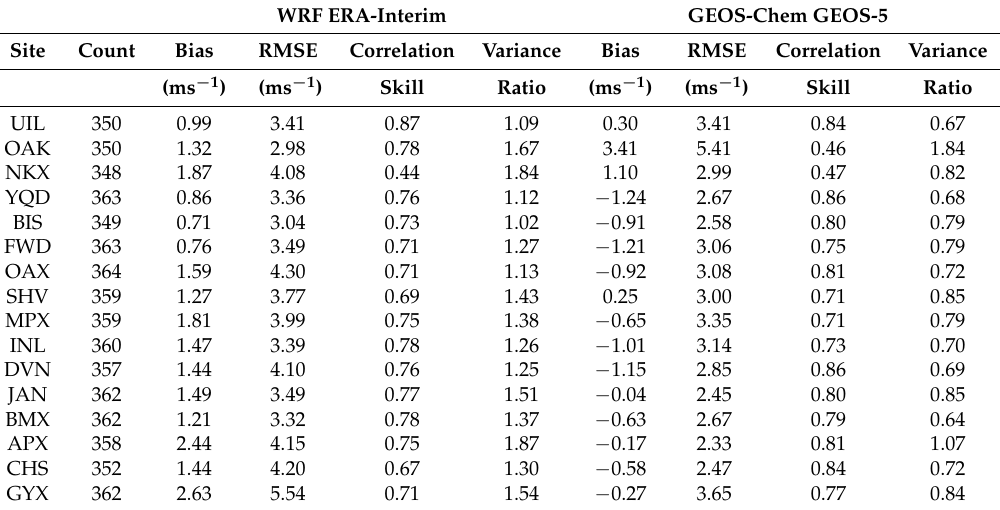
Table 6. Model comparison to rawinsonde wind speed at mandatory reporting level 925 hPa, 00 UTC in